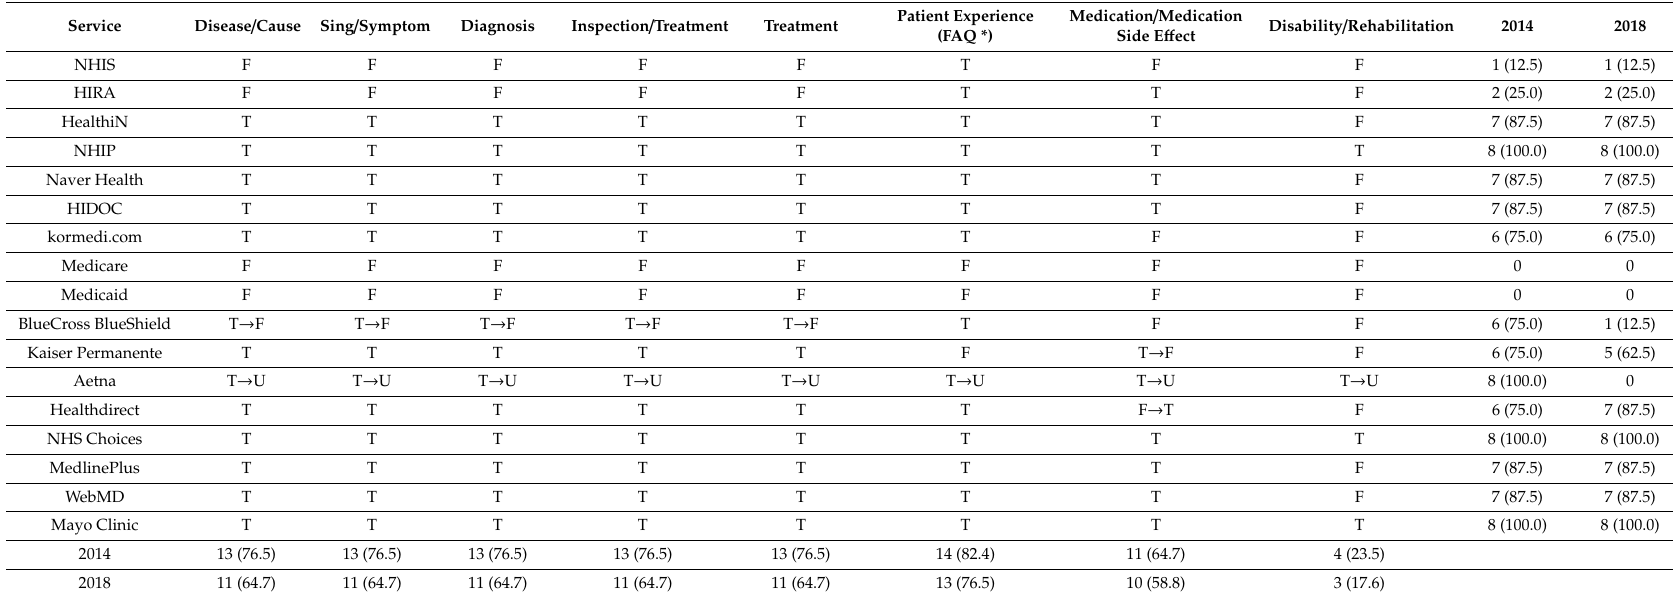
Table 4. Changes in the content scope on health information portals 1 (frequency,